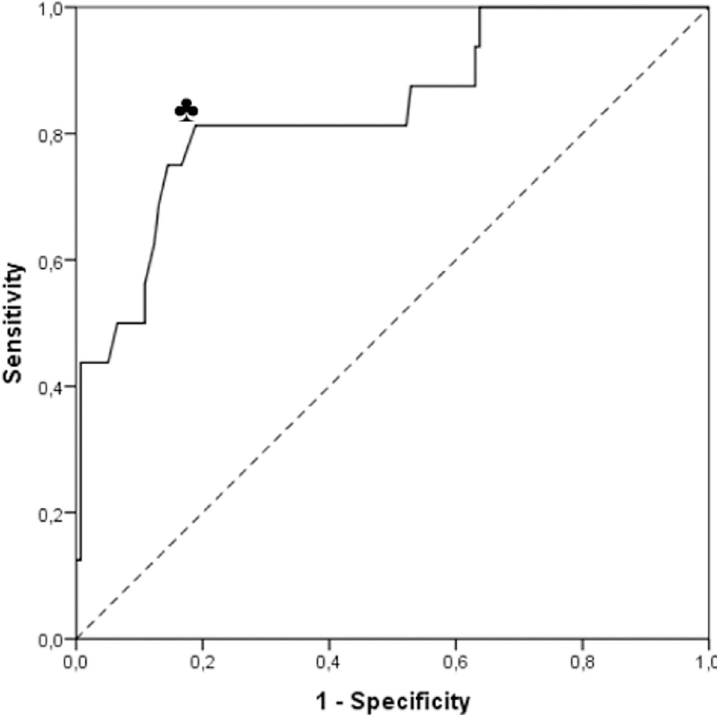
Fig 2. Receiver operating characteristics curve of prediction of Mental Development Index (Bayley’s scales of infant development, 2 nd edition) < 70 from Parent Report Composite score (PARCA-r). ♣ denotes the cut-off score 44 of the Parent Report Composite (PARCA-R) with the best predictive values for identifying infants with a Mental Development Index < 70 (i.e. with mental delay).